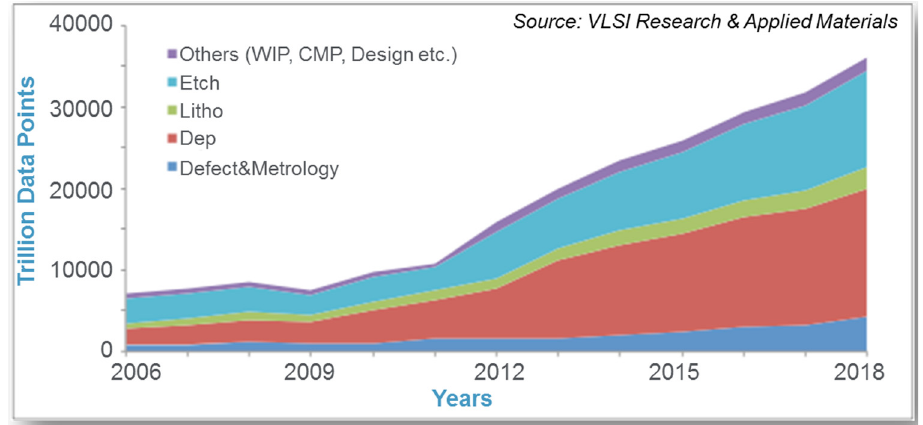
Figure 2. The big data explosion in semiconductor manufacturing, presented in [17], with permission from [17]. Copyright Advanced Process Control Conference, 2016. The different colors refer to the primary process types in the semiconductor “fab”, namely etch, lithography, deposition, defect inspection and other metrology, and others.